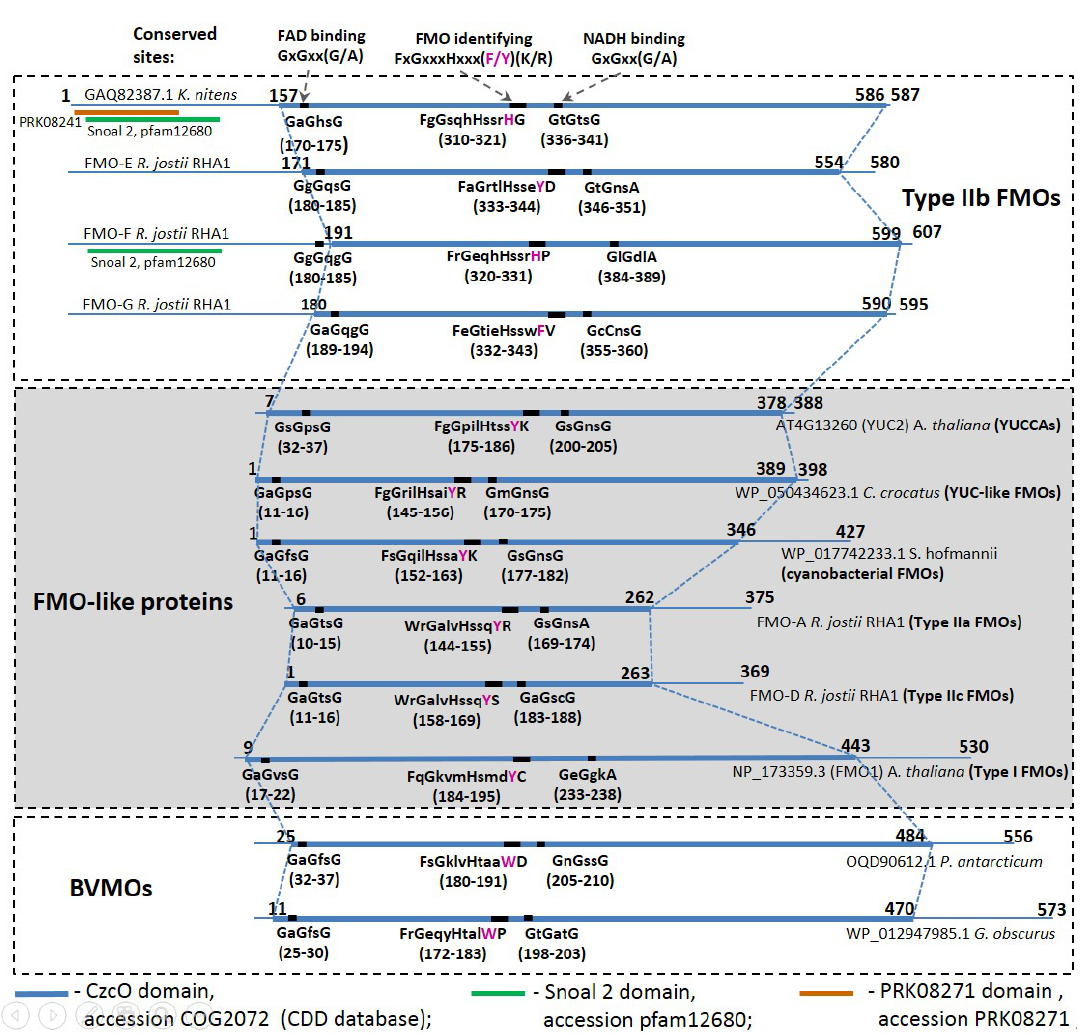
Figure 3. A comparison of the conserved domains of three groups of proteins: type IIb FMOs, FMO-like (YUCCA flavin-containing monooxygenase (YUCCAs), YUC-like FMOs, cyanobacterial FMOs, type IIa FMOs, type IIc FMOs, and type I FMOs), and BVMOs. Blue, green, and brown bold lines show the domains in the protein sequences from CDD (Conserved Domains Database) v. 3.18. Abbreviations: C. crocatus , bacterium Chondromyces crocatus ; S. hofmannii , cyanobacterium Scytonema hofmannii ; P. antarcticum , fungus Penicillium antarcticum; G. obscures , bacterium Geodermatophilus obscures.